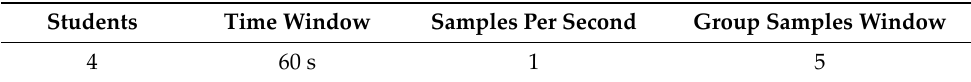
Table 2. Modified settings for third